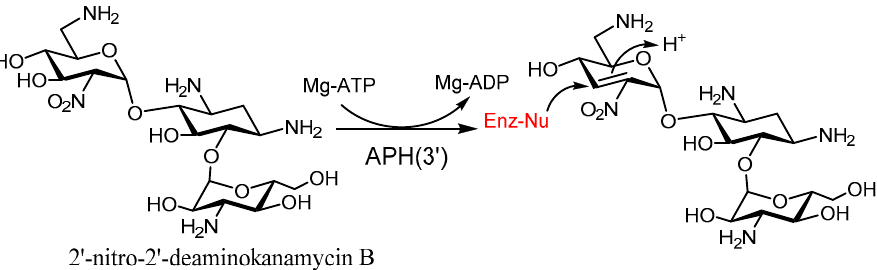
Figure 12. Structure and mode of action of the 2’-nitro-2’deaminokanamycin B.